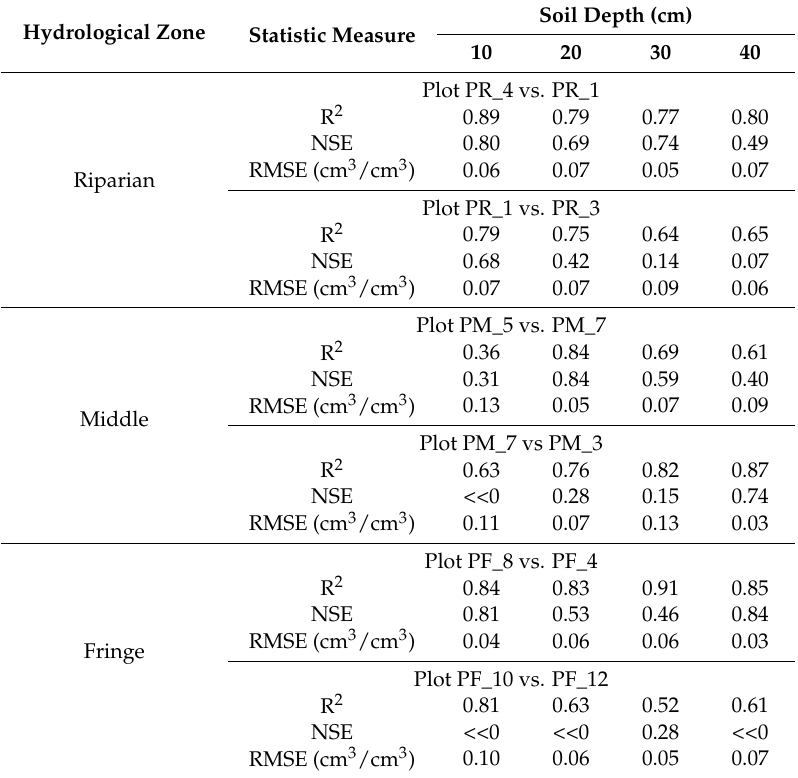
Table 10. Hydrus-1D performance for soil moisture simulation after